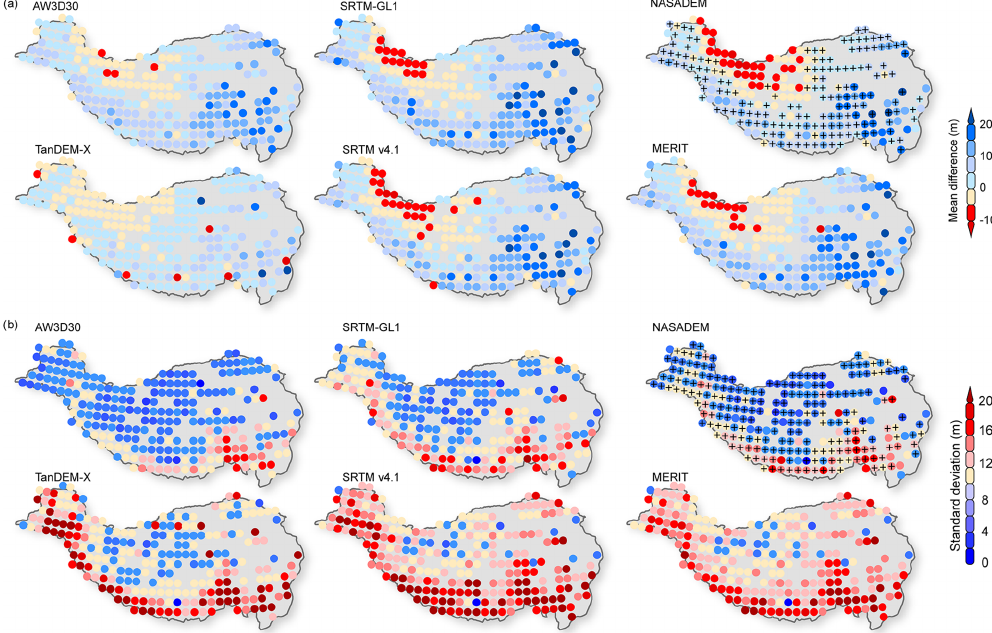
Figure 5. Aggregated spatial mean error (ME) (a) and standard deviation (SD) (b) between six DEMs and ICESat-2 elevation for 1 ◦ × 1 ◦ cells across the TP. The cross symbol denotes that NASADEM performs better than SRTM-GL1 in ME or